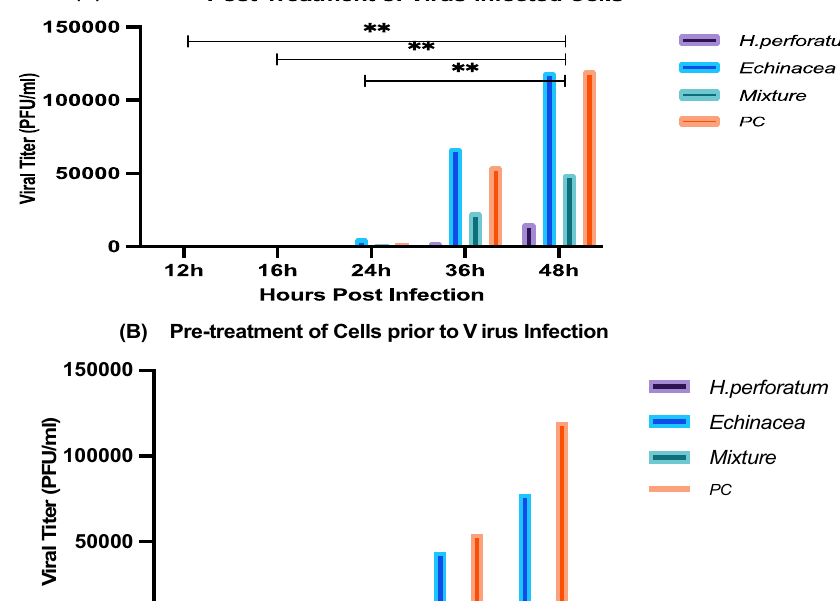
While, in the case of SARS-CoV-2 RdRp re-docking analysis Echinacoside (− 9.0 kcal/mol) and Rutin (− 8.0 kcal/mol) from E. angustifolia , Kaempferol-3-O-rutinoside (− 9.3 kcal/mol) and Echinacoside (− 9.2 kcal/mol) from E. purpurea , and Rutin (− 9.2 kcal/mol) and Quercetin-3-O-xyloside (− 9.0 kcal/mol) from H. perforatum showed significant binding energy with the target protein. These observed binding energies for the above com- pounds are much better than control ligand Remdesivir (− 7.6 kcal/mol), and some previously reported FDA approved drugs, which were repurposed against SARS-CoV-2 60,61 . This suggests that all the above reported compounds may be the potential inhibitors of both SARS-CoV-2 drug targets. The molecular interaction analysis results revealed the formation of good molecular contacts with catalytic residues and other substrate binding residues (Tables 1 and 2).